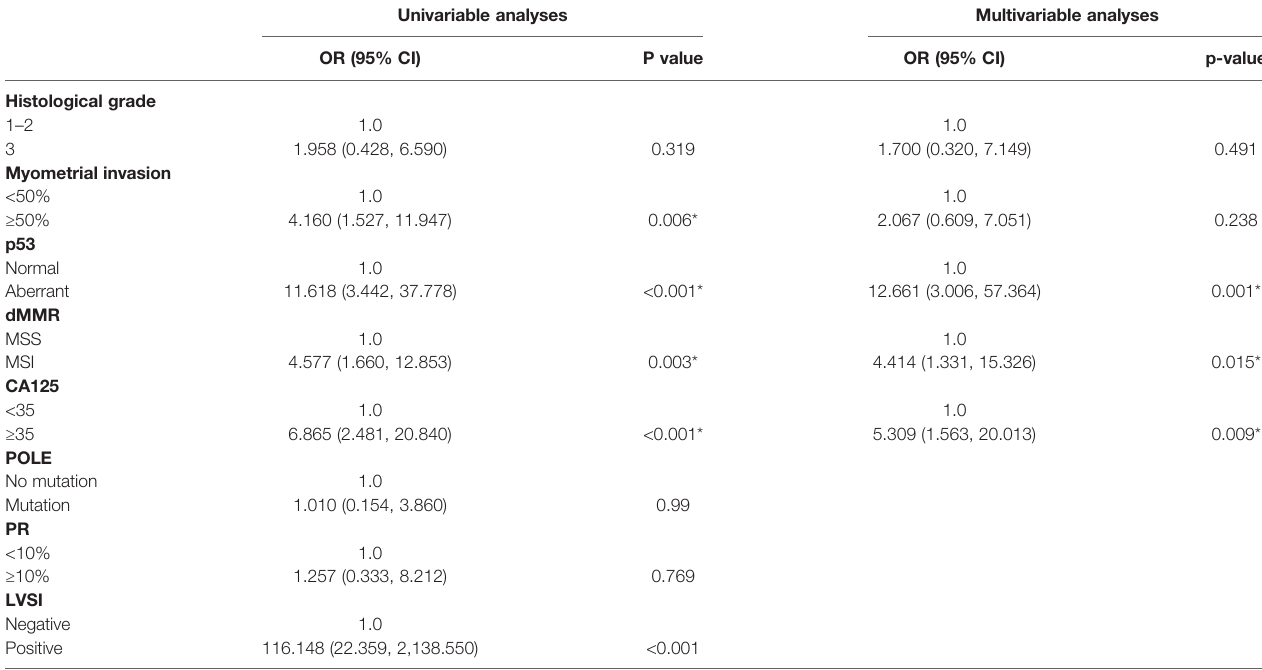
TABLE 2 | Univariate and multivariate analysis of lymph node